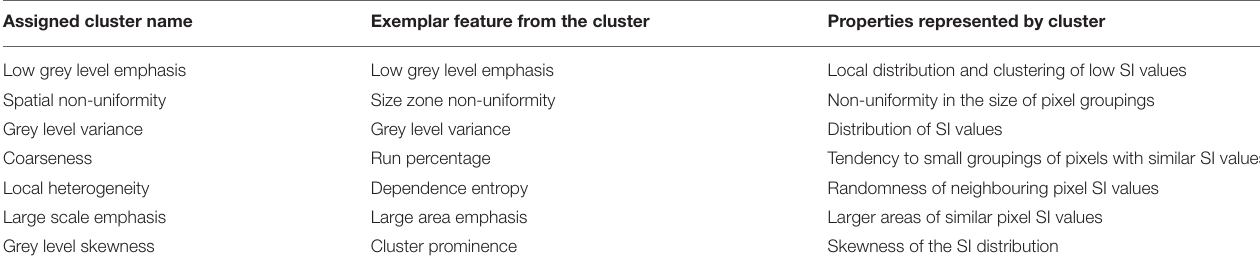
TABLE 3 | Description of clusters identified from the radiomics texture